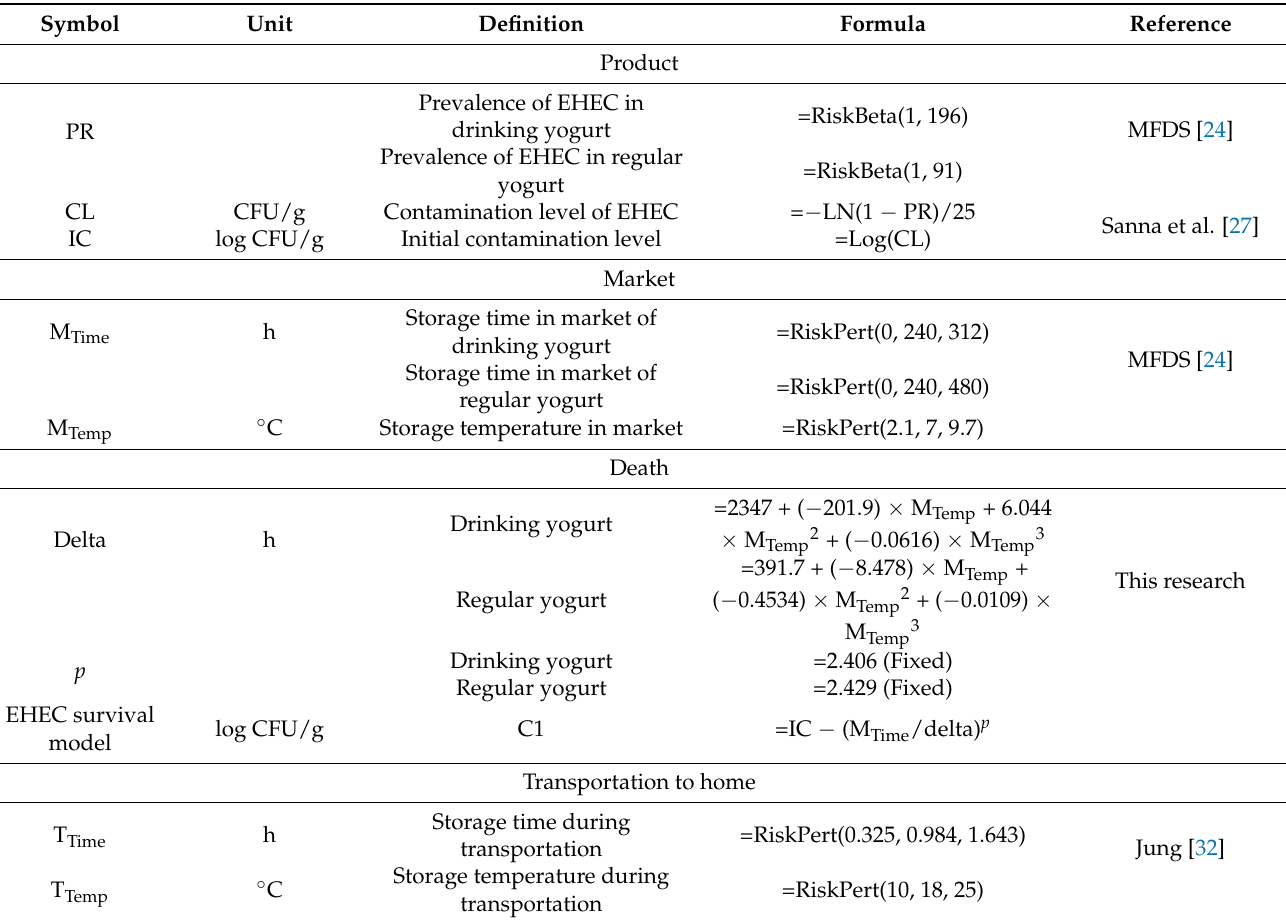
Table 3. Simulation model and formulas in the Excel spreadsheet used to calculate the risk of EHEC in drinking and regular yogurt with